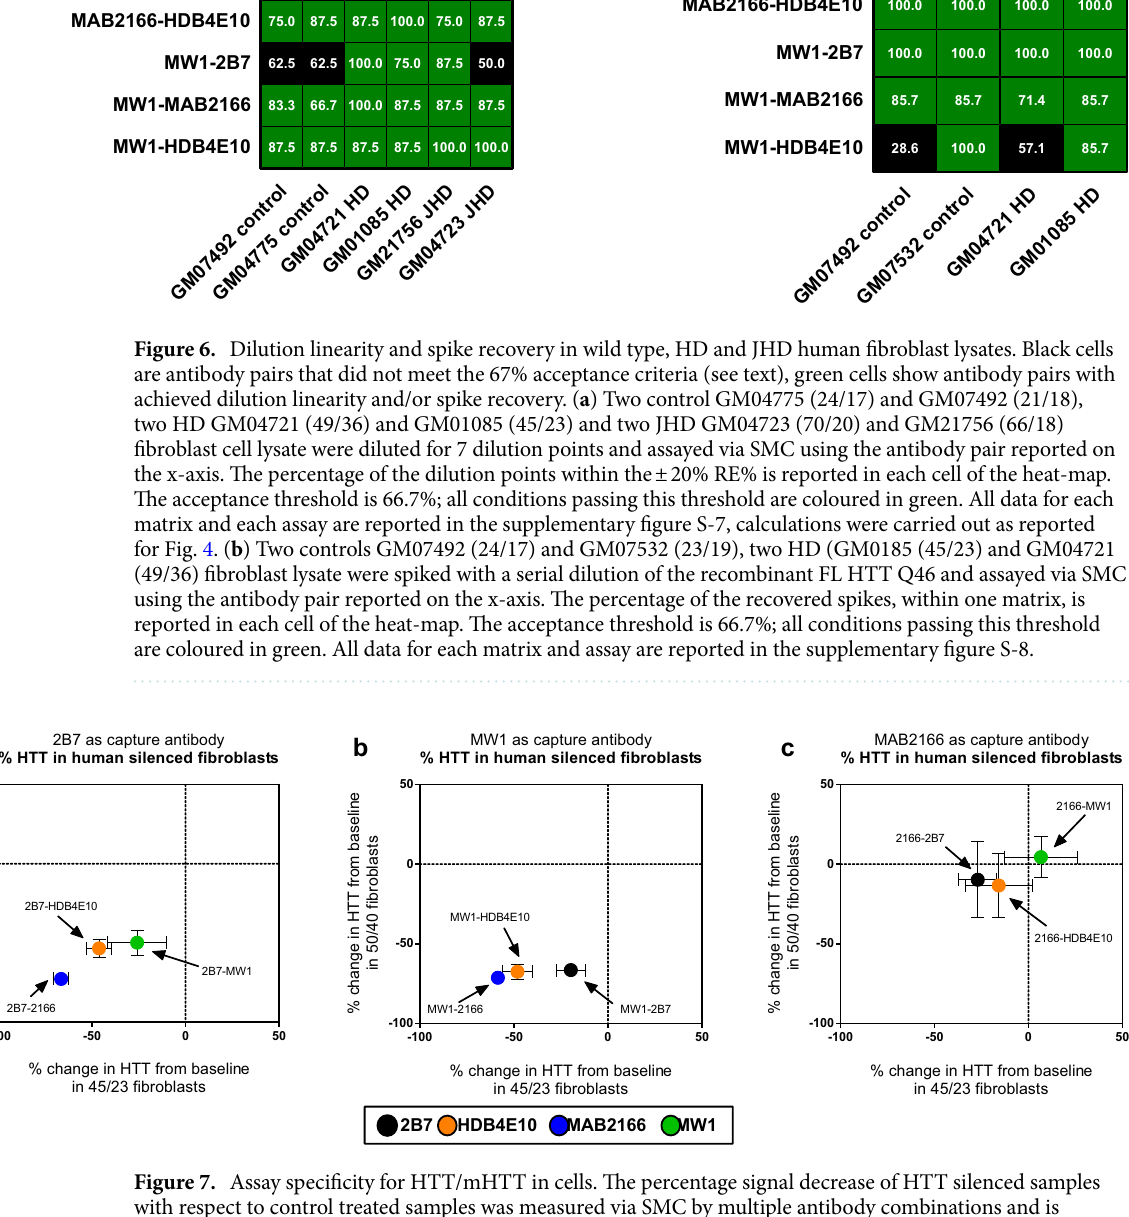
Figure 7. Assay specificity for HTT/mHTT in cells. The percentage signal decrease of HTT silenced samples with respect to control treated samples was measured via SMC by multiple antibody combinations and is reported on the x-axis for GM01085 (45/23) and on the y-axis for GM04857 (50/40). All numeric results are available in S-9. The leftmost group reports the result of the assays with the 2B7 antibody as capture. The middle panel reports the result of the assays with the MW1 antibody as capture, whereas the rightmost panel reports the result of the assays with the MAB2166 as capture antibody. Each colour represents a different detection antibody as reported in the legend. Each result is presented as the average and standard deviation of three independent experiments. Validation of the silencing via Western blot is presented in the supplementary material S-9. Each experimental point is reported as the average and standard deviations of a